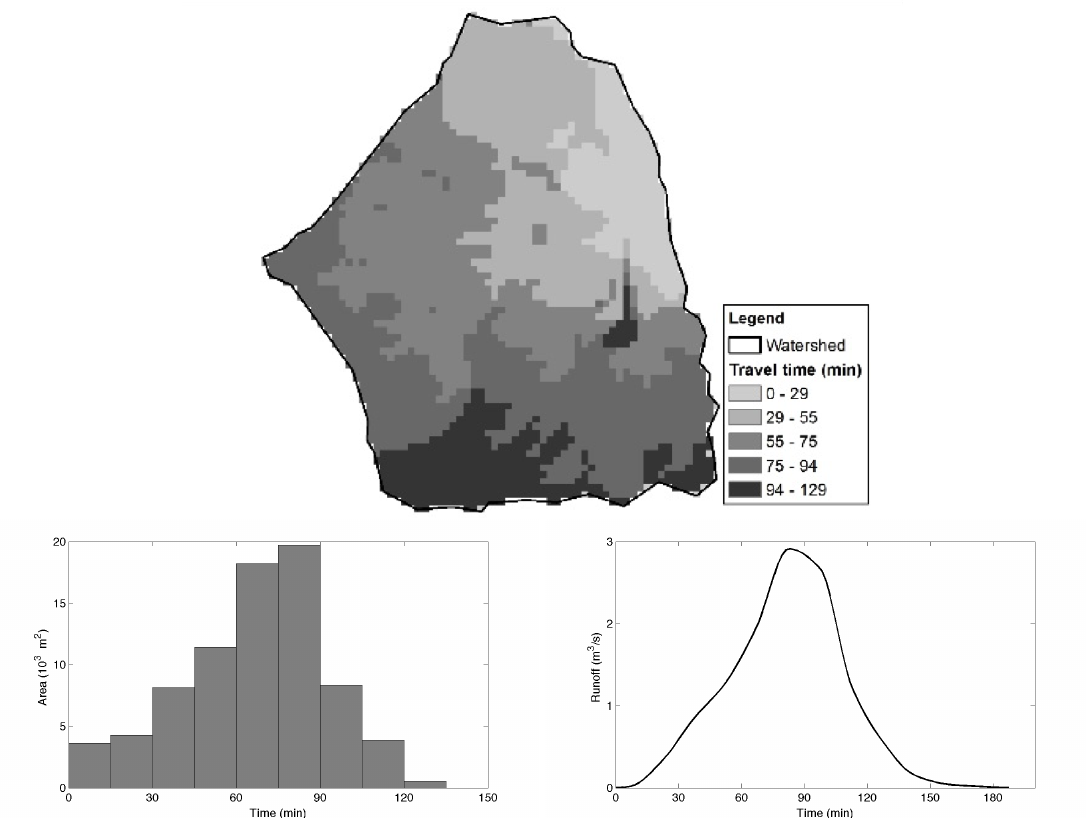
Figure 9. Figure showing travel time map ( on the top ), time area histogram ( on the bottom left ), and runoff hydrograph ( on the bottom right ) of the Blacklot